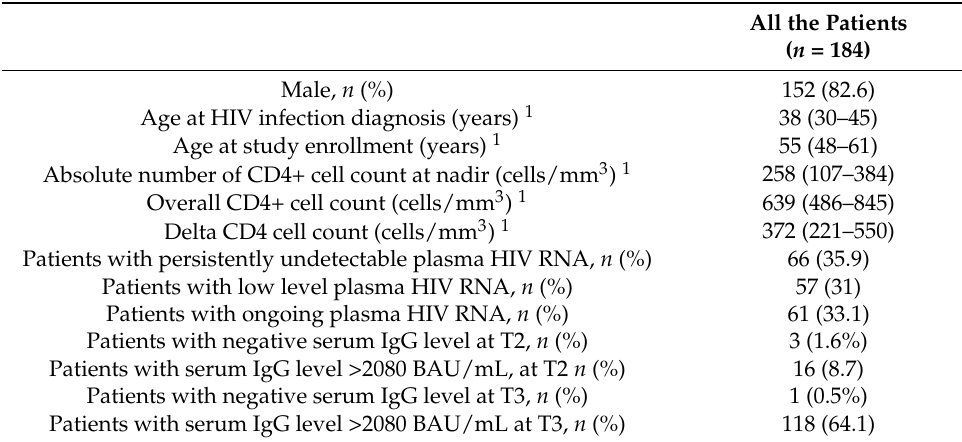
Table 1. Main characteristics of the study population.